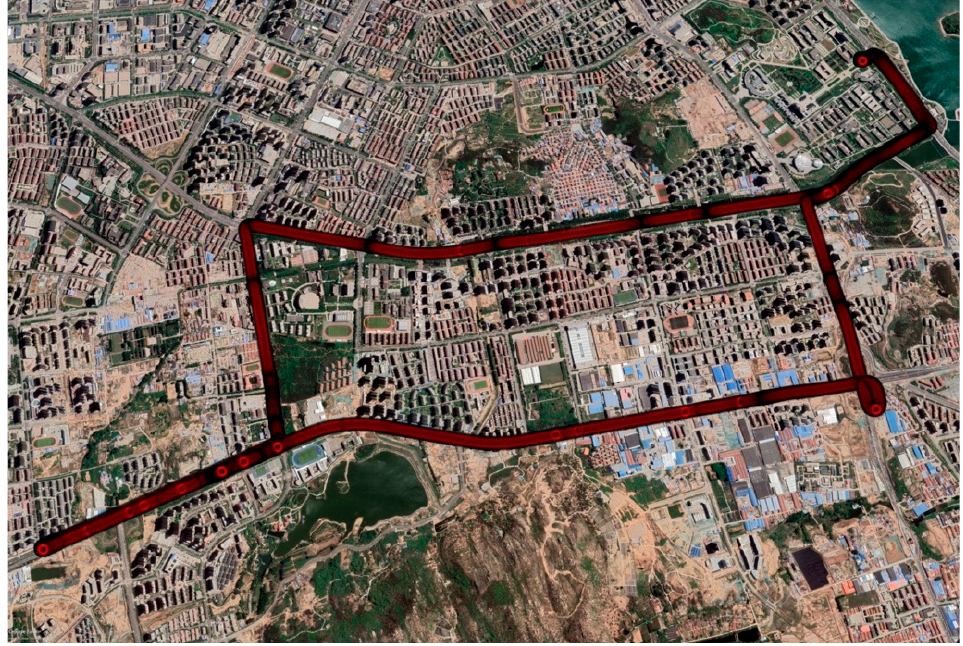
Figure 7. The trajectory of the land vehicle in Experiment B.